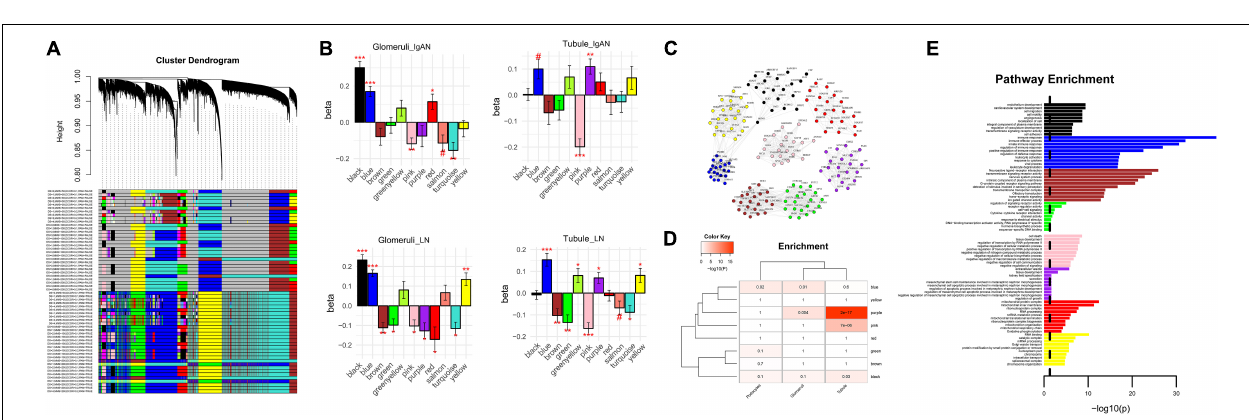
FIGURE 2 | Gene expression pattern overlap across the diseases. (A) Rank order of the microarray transcriptome similarity between peripheral blood mononuclear cell (PBMC) and renal tissue pairs in both diseases as measured by Spearman’s correlation of differential expression (log2FC) values. (B) RNAseq results replicate the gradient of transcriptomic severity observed from microarray data, as measured by the regression slope, with LN-Glo > IgAN-Glo > LN-Tu > IgAN-Tu. Spearman’s ρ is shown for comparison between the microarray and region-specific RNAseq replication datasets (all P < 10 − 14 ). Data represent the mean ± SEM. * P < 0.05, ** P < 0.01, and *** P < 0.001.